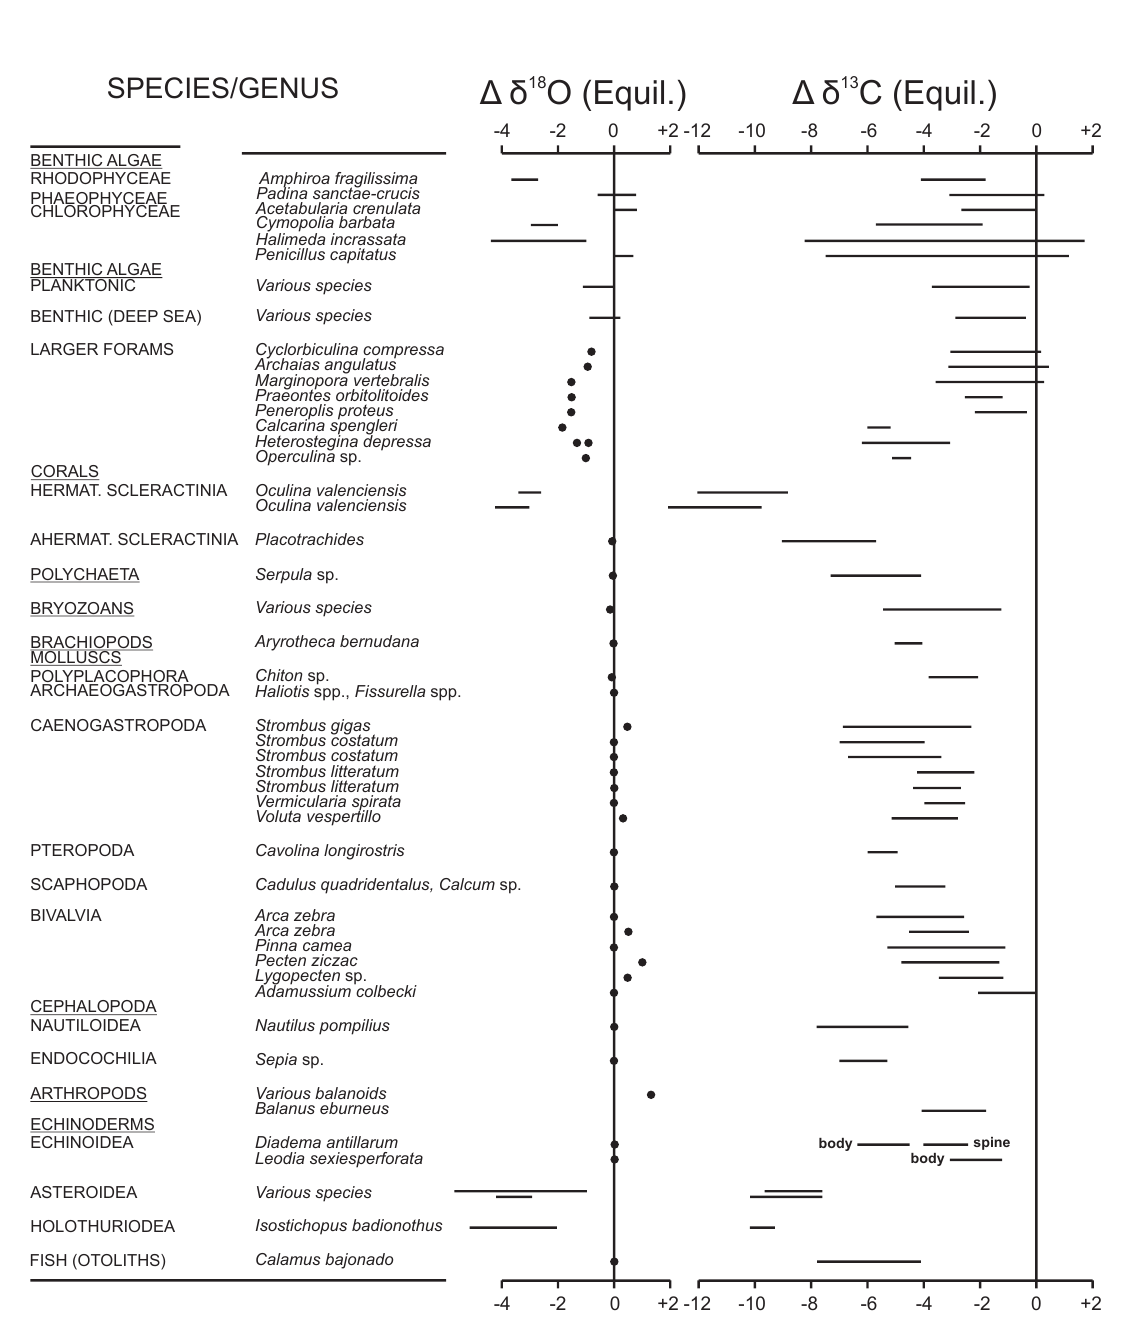
Figure 7. Oxygen (and carbon) isotope departures from isotope equilibrium in recent calcareous skeletons of various animal groups (reproduced with permission from Wefer and Berger [206]. “Isotope paleontology: growth and composition of extant calcareous species”. Marine Geology, 1991, v. 100, p. 207–248. Copyright Elsevier